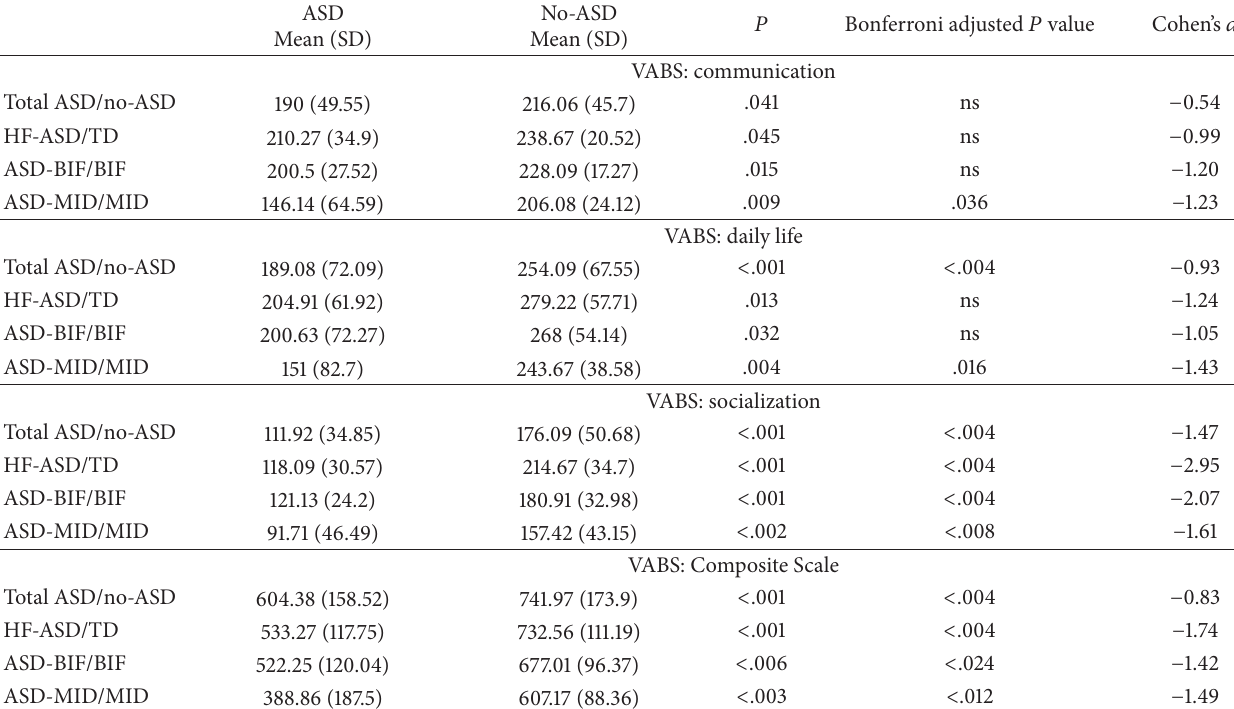
Table 5: Means, SD, and statistically significant differences ( 𝑡 test; Bonferronicorrection: 𝑃 ≤ .0125 ; Cohen’s test) obtained from experimental and control groups at VABS.